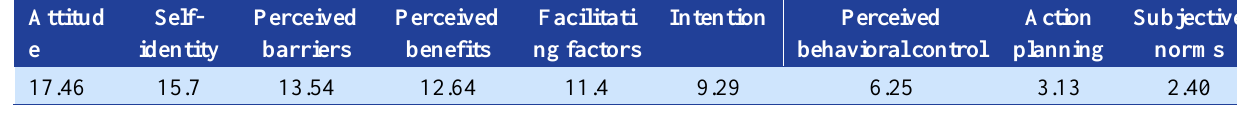
Table 3. Total variance of exploratory factor analysis